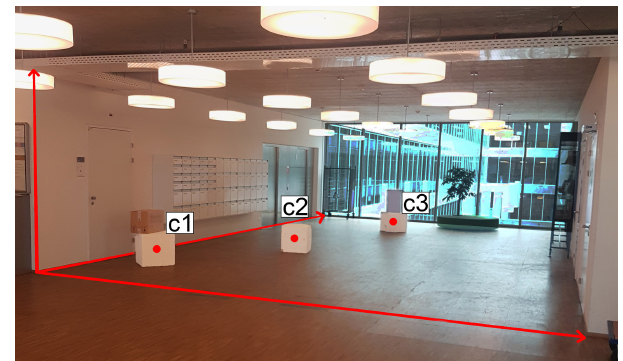
Figure 4. Picture of the scanned scene for lidar and distance com- parison. The letters c1, c2 and c3 represent cubes of 0 . 5m × 0 . 5m × 0 . 5m. The red arrows are the length, width and height of the ceiling.